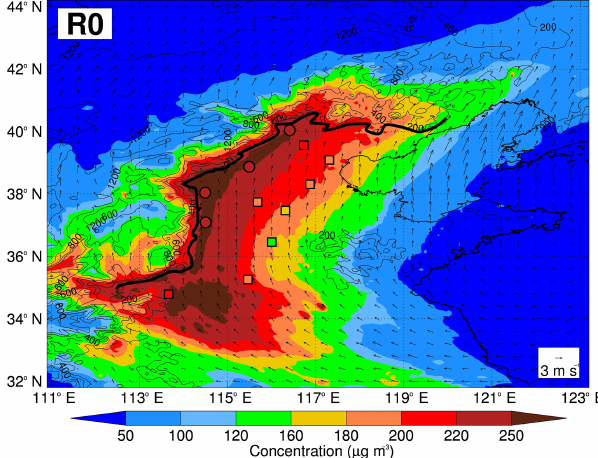
Figure 10. The elevation contours and the pattern comparisons of simulated vs. observed near-surface PM 2 . 5 concentrations from 12:00 to 00:00LT on 7 to 10 Oct. Colored circles: PM 2 . 5 observa- tions of foothill sites; Colored squares: PM 2 . 5 observations of non- foothill sites; Black arrows: simulated surface winds. The 200m contour was highlighted with bold black